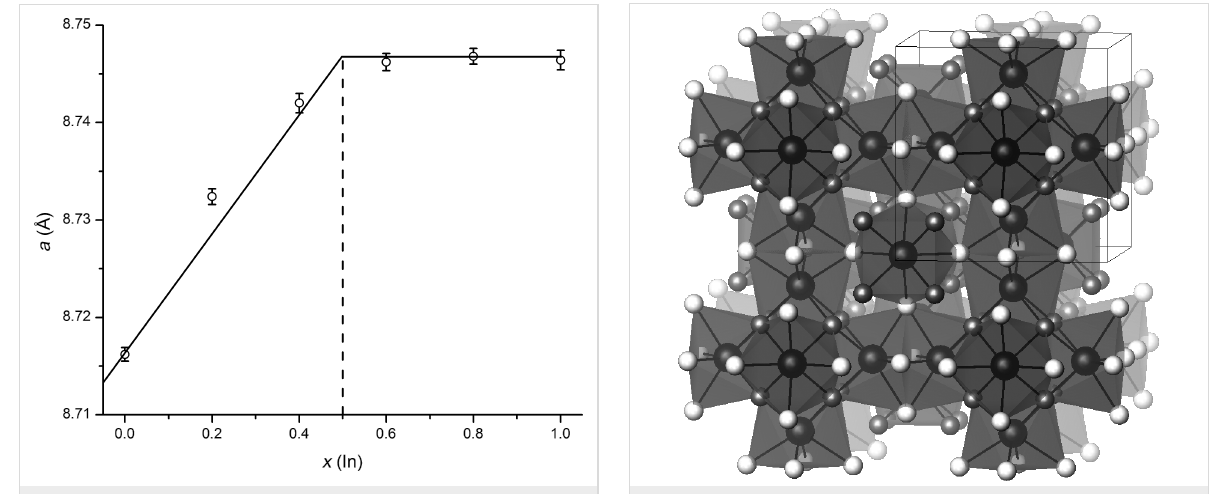
Figure 3: Polyhedral view of the Re 3 As 7 − x In x crystal structure. Re is shown as black spheres inside the polyhedra, E1: white spheres, and As2: gray spheres at the